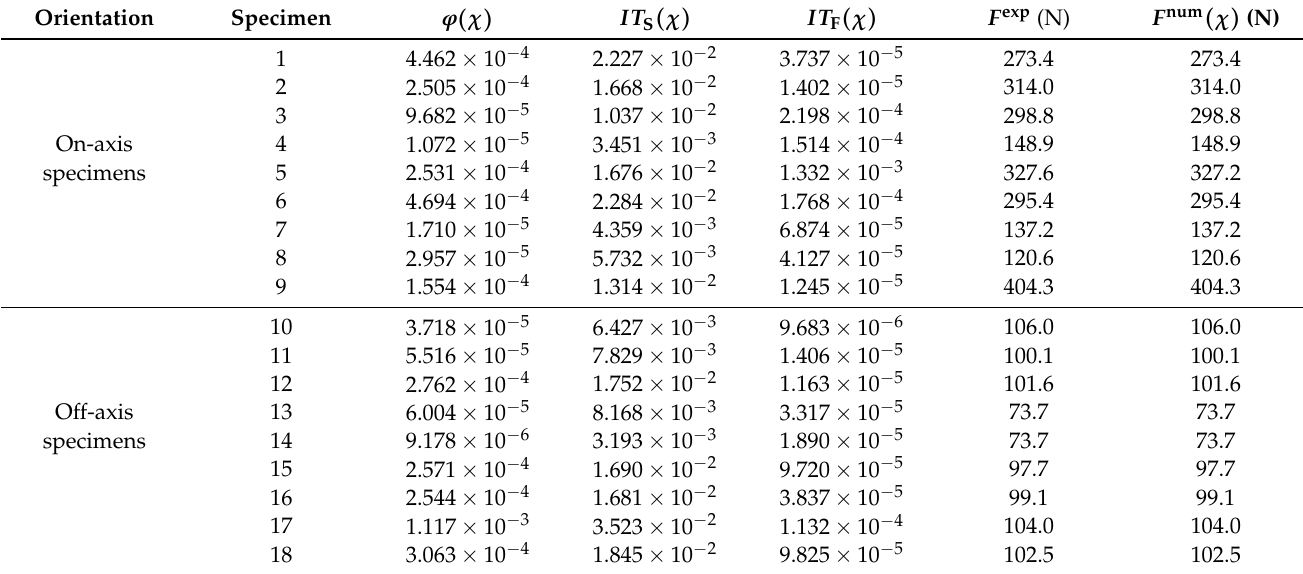
Table 7. Summary of the OF terms at the end of the identification procedure using FEMU.